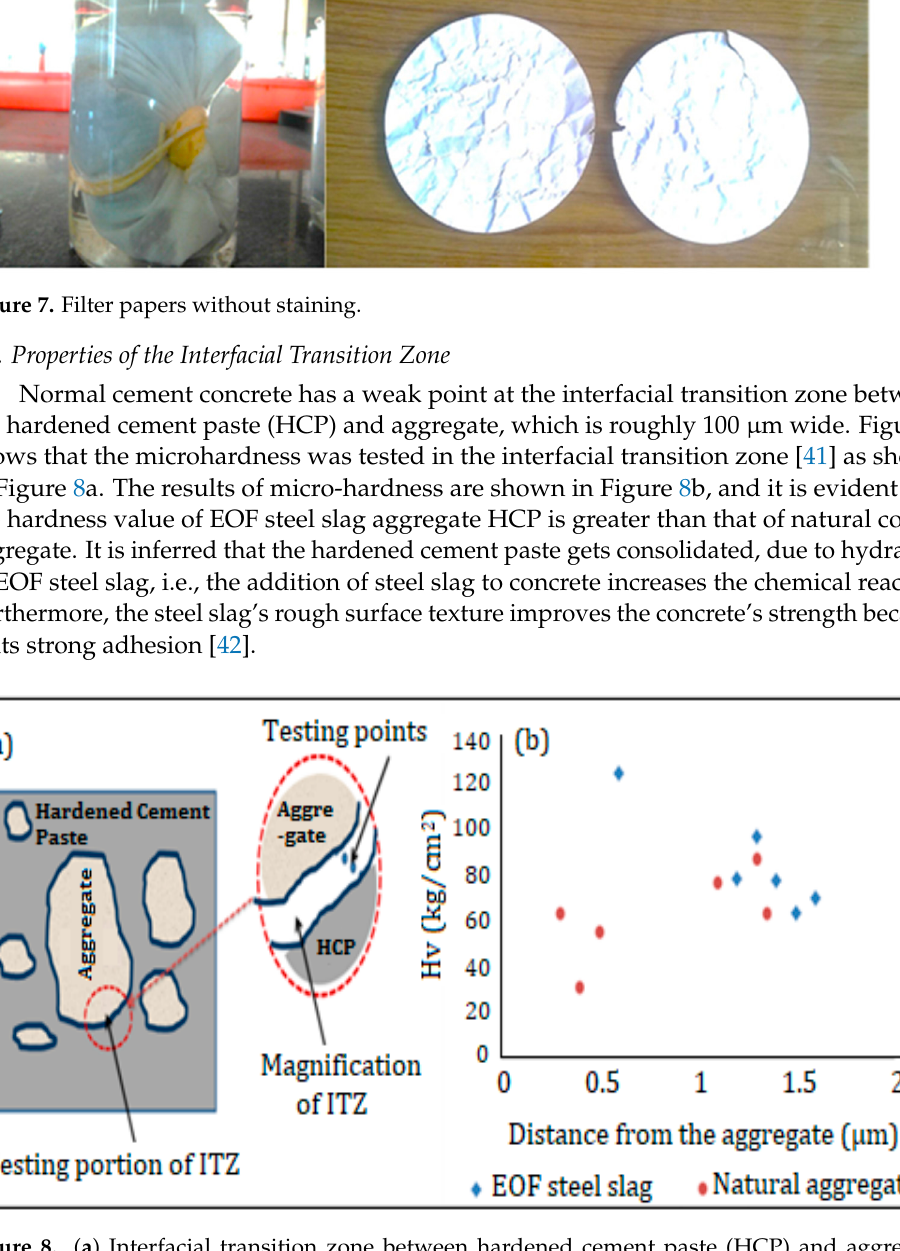
Figure 8. ( a ) Interfacial transition zone between hardened cement paste (HCP) and aggregate, ( b ) Micro hardness value of interfacial transition zone.